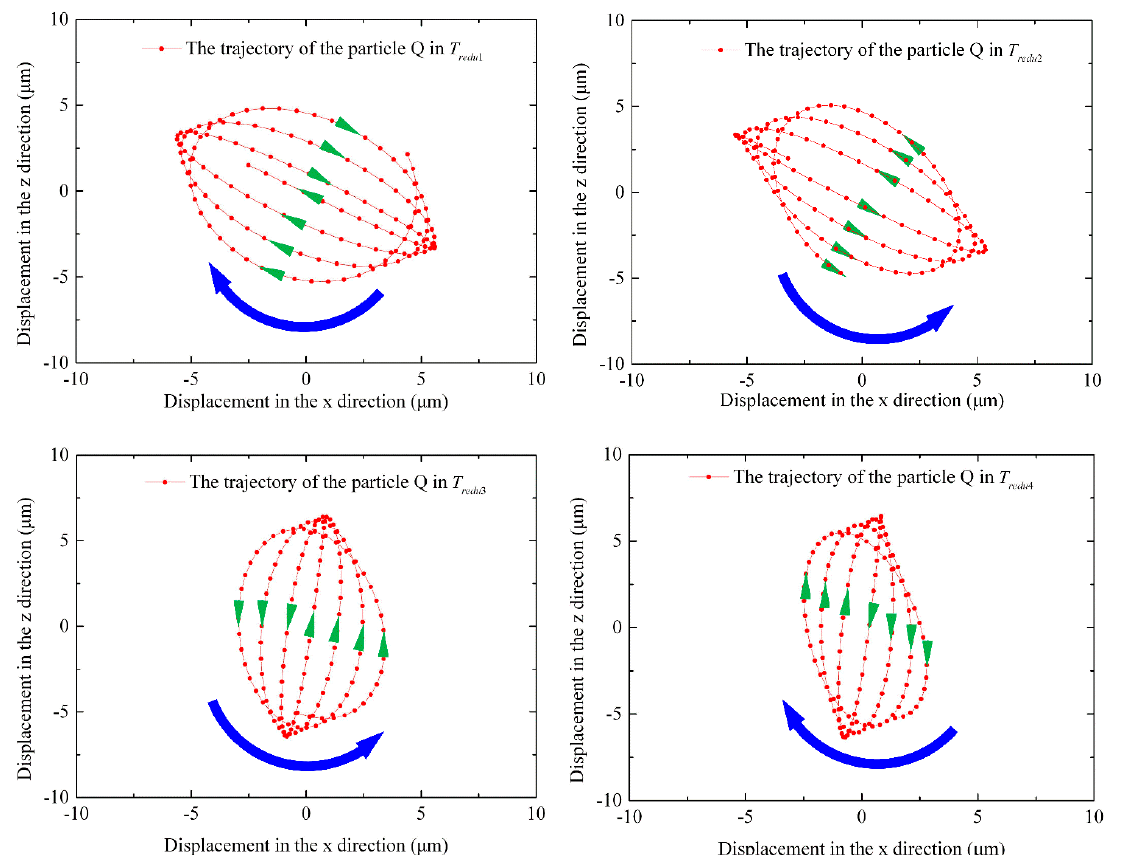
Figure 9. Elliptical trajectory of particle Q. According to Equation (12) and Equation (24), the simulation curves of the vertical displacement of particle point Q, 𝜁 (cid:3053) (𝑡) , and the determining factor equation of the ellipti- cal motion direction, 𝑄 (cid:3044)(cid:3045)(cid:3032)(cid:3031)(cid:3048) (𝑡) , are obtained, respectively. As shown in Figure 10, there is one beat period in 𝑇 (cid:3045)(cid:3032)(cid:3031)(cid:3048)(cid:3021) is 𝑇 (cid:3045)(cid:3032)(cid:3031)(cid:3048) , and one beat pe- riod is divided into four-beat miniperiods, 𝑇 (cid:3045)(cid:3032)(cid:3031)(cid:3048)(cid:2869) ∽ 𝑇 (cid:3045)(cid:3032)(cid:3031)(cid:3048)(cid:2872) , on average (see Figure 9). The particle point Q moves clockwise in the first and fourth beat miniperiods ( 𝑇 (cid:3045)(cid:3032)(cid:3031)(cid:3048)(cid:2869) and 𝑇 (cid:3045)(cid:3032)(cid:3031)(cid:3048)(cid:2872) ), while the middle two small periods of the beat wave ( 𝑇 (cid:3045)(cid:3032)(cid:3031)(cid:3048)(cid:2870) and 𝑇 (cid:3045)(cid:3032)(cid:3031)(cid:3048)(cid:2871) ) move counterclockwise. In this paper, the clockwise direction is set as the positive direction, and the counterclockwise direction is set as the negative direction. It can be found that the change trend of the positive and negative signs of the determinant value of Formula 𝑄 (cid:3044)(cid:3045)(cid:3032)(cid:3031)(cid:3048) (𝑡) is consistent with the rotation direction of particle Q in Figure 11. Additionally, the change trend for the value of the determining factor of the elliptical motion direction, 𝑄 (cid:3044)(cid:3045)(cid:3032)(cid:3031)(cid:3048) (𝑡) , and the tangential velocity of particle point H, 𝑣 (cid:3051)(cid:3040)(cid:3028)(cid:3051) (𝑡) , at the wave peak is also consistent.